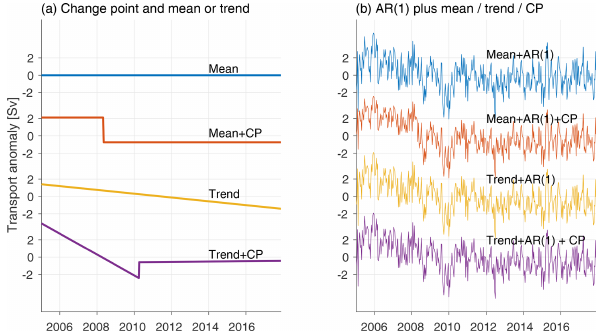
Figure 5. Change-point analysis of the AMOC–Ekman time series. In panel (a) , only a mean or a trend, with or without a change point is fit. In panel (b) , an AR(1) is also fit. The model with the best overall fit is the Mean + AR(1) + CP model (red, right) according to the AIC (see Table 2), indicating that the time series can best be explained by an AR(1) time series with a change in the mean in